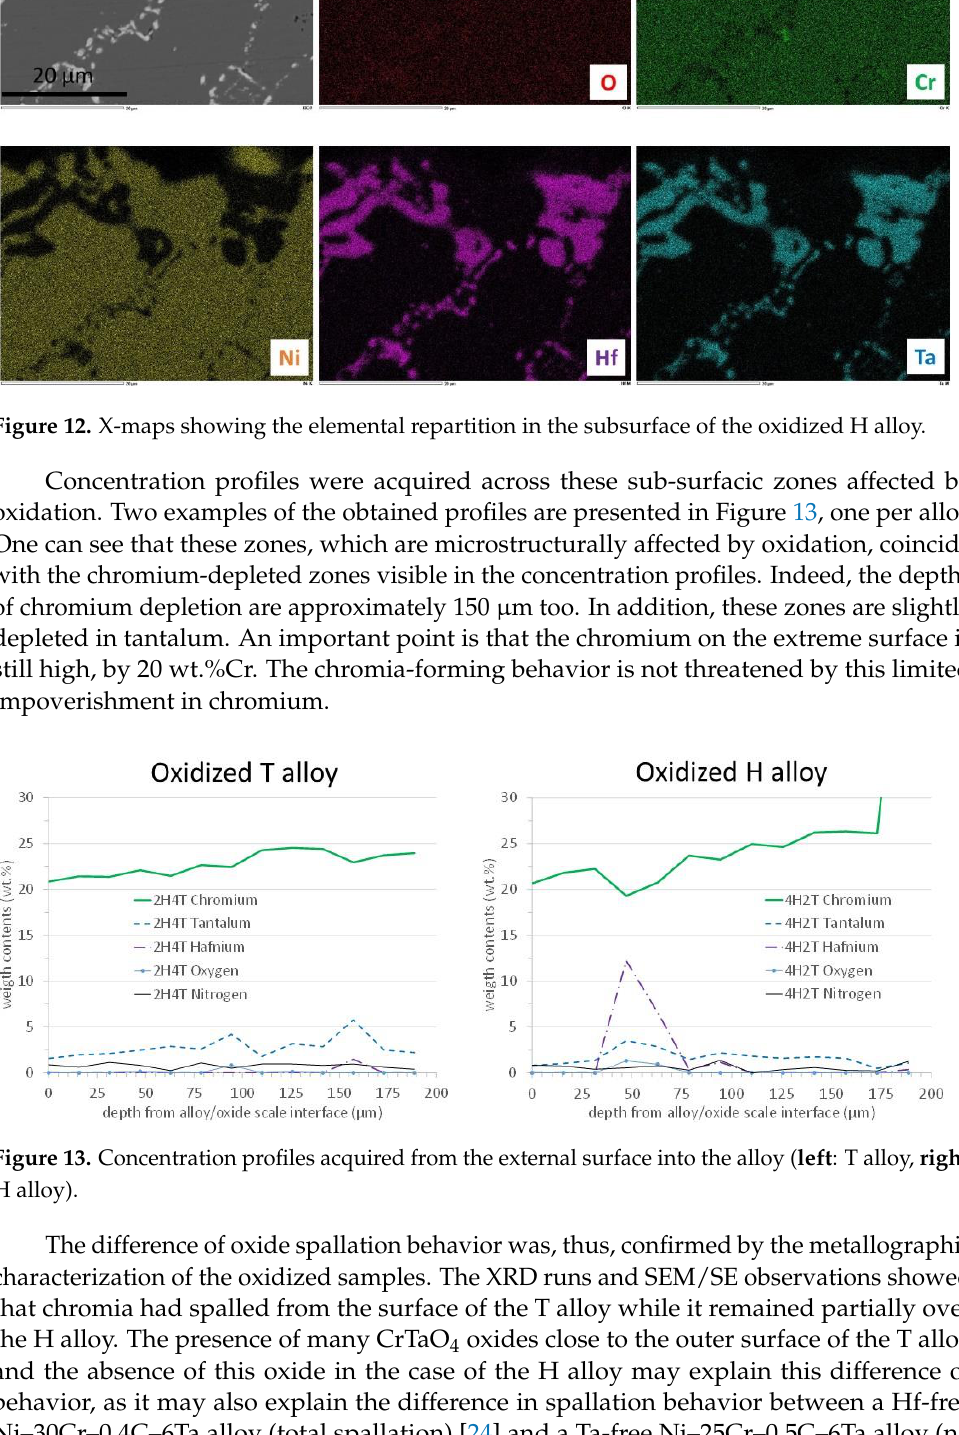
Figure 11. X-maps showing the elemental repartition in the subsurface of the oxidized T alloy.